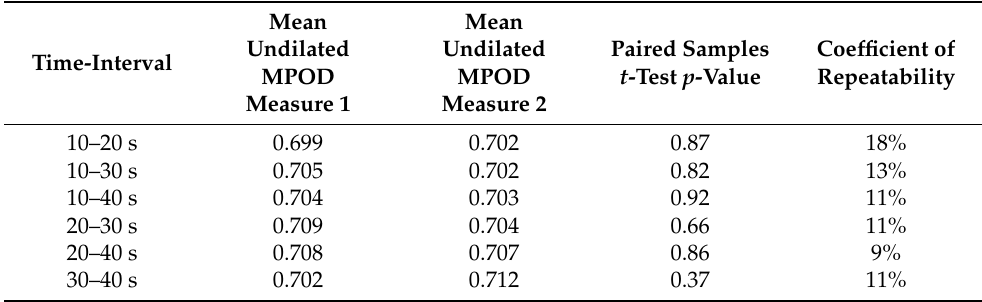
Table 1. Mean MPOD obtained using the Macular Pigment Reflectometry without pupillary dilation.